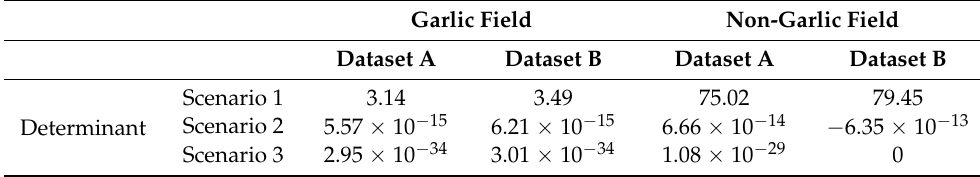
Table 11. Determinant of the variance-covariance matrix for datasets A and B.